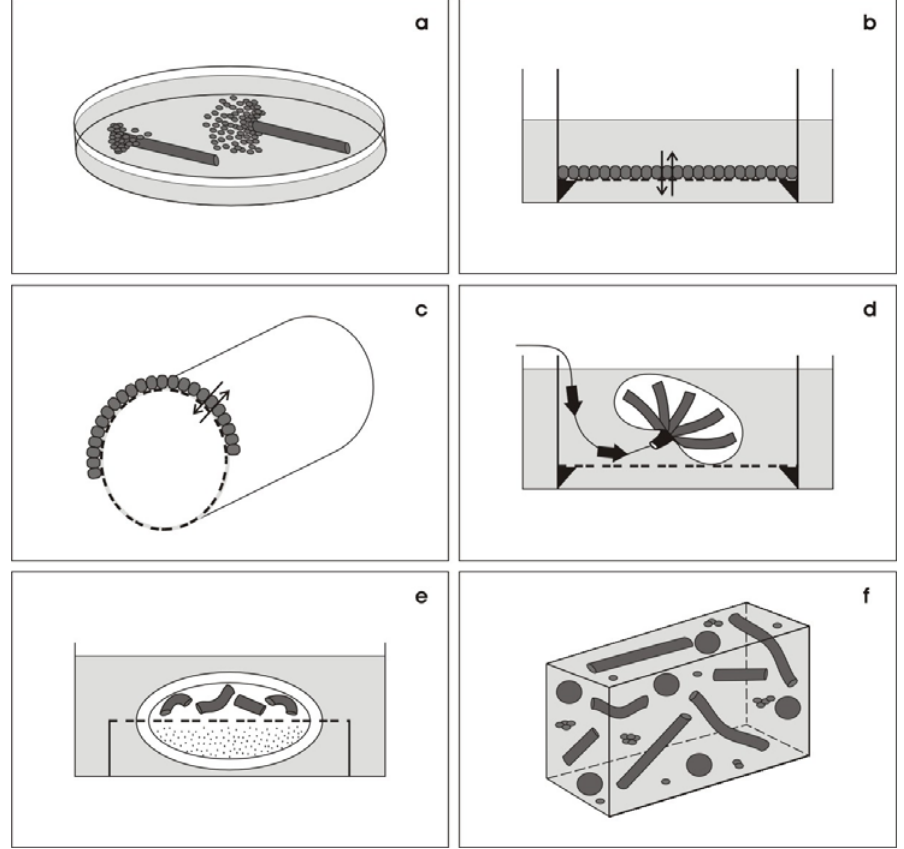
Figure 1. (a) Schematic illustration of culture techniques for renal cell s . (a) When tubule segments are cultured in medium containing serum, cells emigrate and spread on the bottom of the culture dish and on the outer side of the tubule basal lamina. (b) To offer a substitute for the basal lamina, renal cells are kept on various filter materials supporting exchange of fluid between the luminal and basal side s . (c) A fully biocompatible surface on hollow fibers is needed, when renal cells have to perform intense transport of molecules. (d) Culture of an intact organ anlage promotes spatial development of